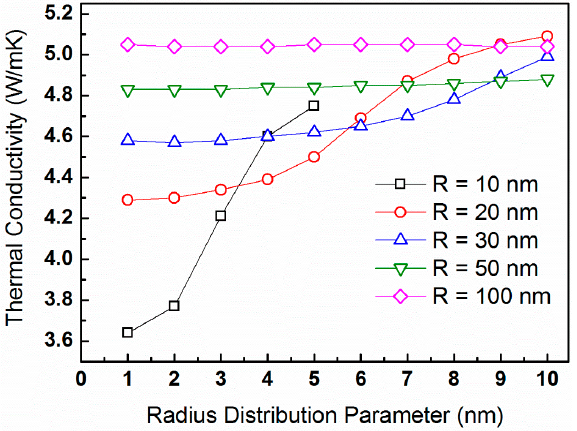
Figure 6. The lattice thermal conductivity of PbTe calculated from expression (16) for constant temperature of T = 300 K and precipitate volume fraction of v f = 5% as a function of the ∆ R -parameter. The calculations are for average radii of R o = 10, 20, 30, 50, and 100 nm, denoted by black squares, red circles, blue upward triangles, green downward triangles, and magenta diamonds, respectively.